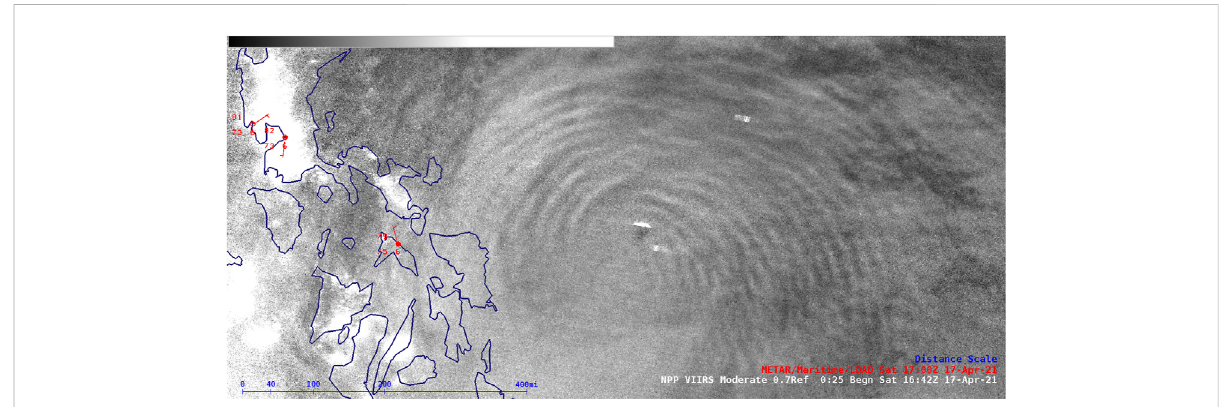
FIGURE 10 A nocturnal (several hours before sunrise) Suomi-NPP VIIRS Day/Night Band image (0.7 μ m) showing concentric mesospheric airglow waves thathavepropagatedupwardfromtheconvectivecoreofSuperTyphoonSurigaenearthetimeofitspeakintensityon17April2021,whenitwasjust east of the Philippines. From Bachmeier